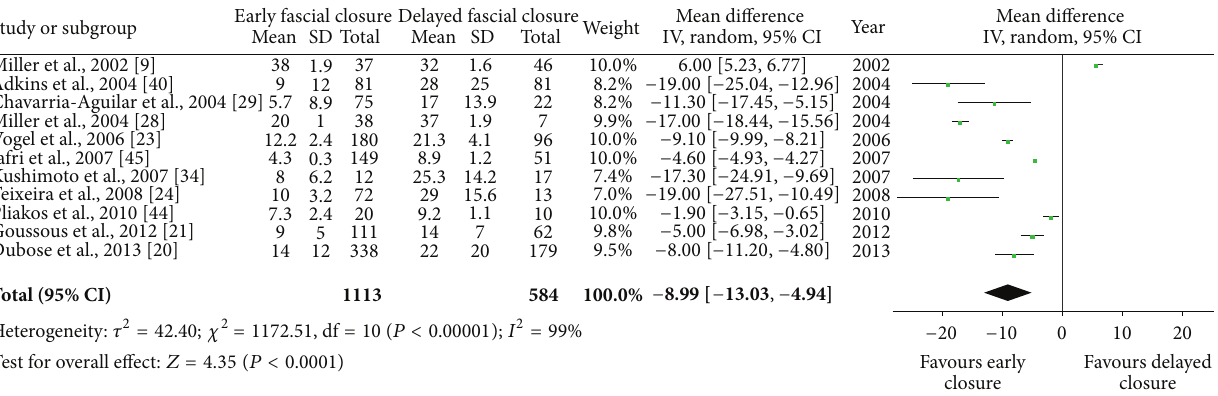
Figure 3: The mean length of ICU stay in early fascial or delayed closure populations. Estimated SD values in some trials were calculated from five percent of correlated mean values.